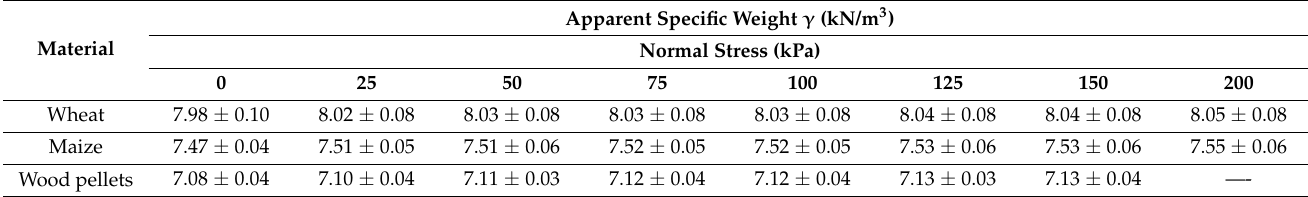
Table 7. Change in apparent specific weight of the materials at different normal